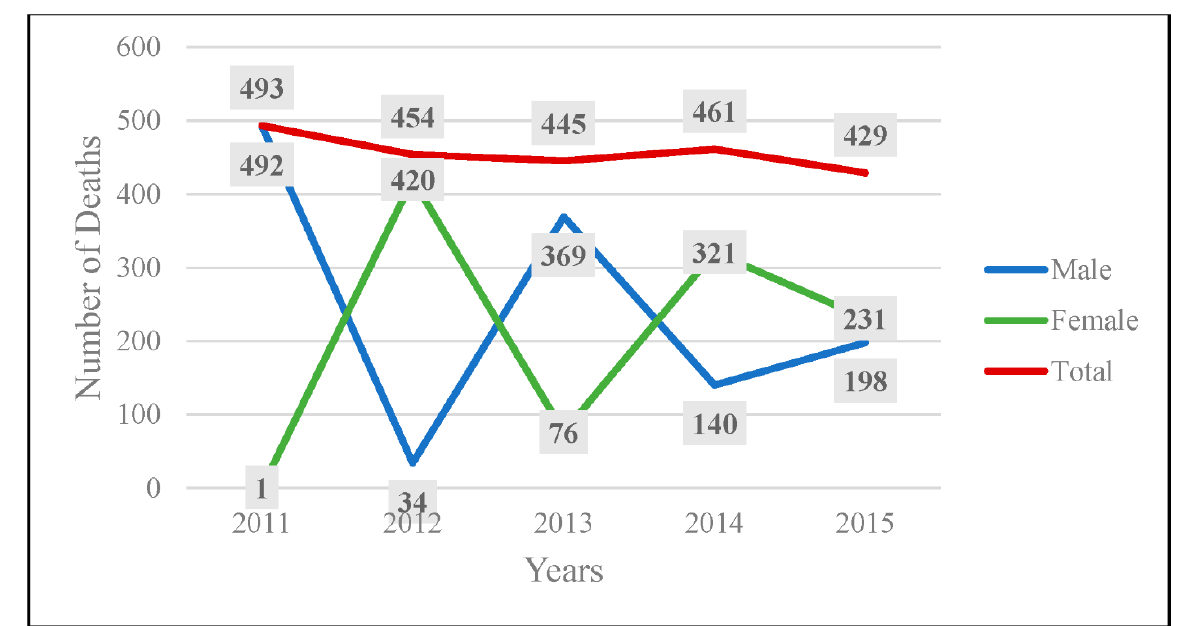
Figure 2. Total deaths resulting from road traffic accidents by gender in Kuwait from 2011 to 2015.